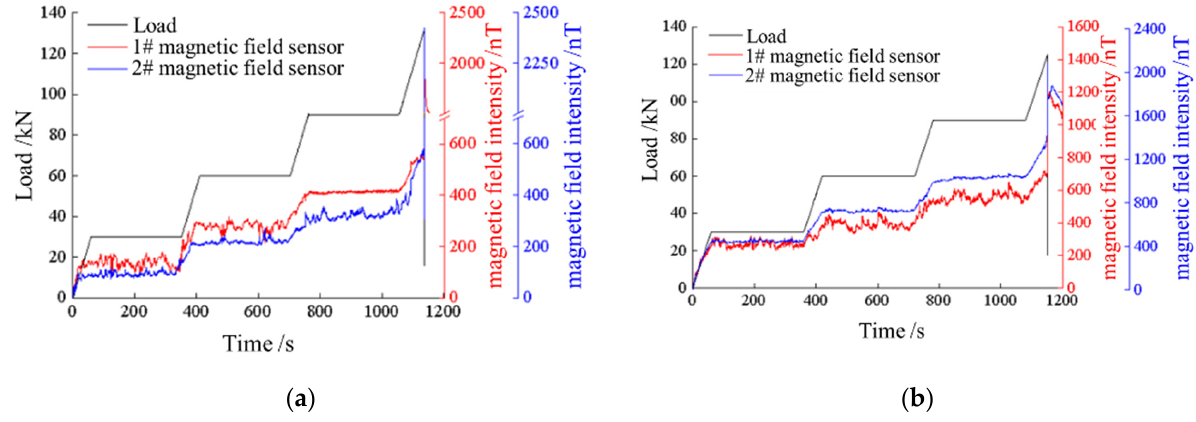
Figure 7. Load ‐ magnetic curve of concrete during grading loading. ( a ) Sample g1, ( b ) Sample g2. Figure 7. Load-magnetic curve of concrete during grading loading.( a ) Sample g1, ( b ) Sample